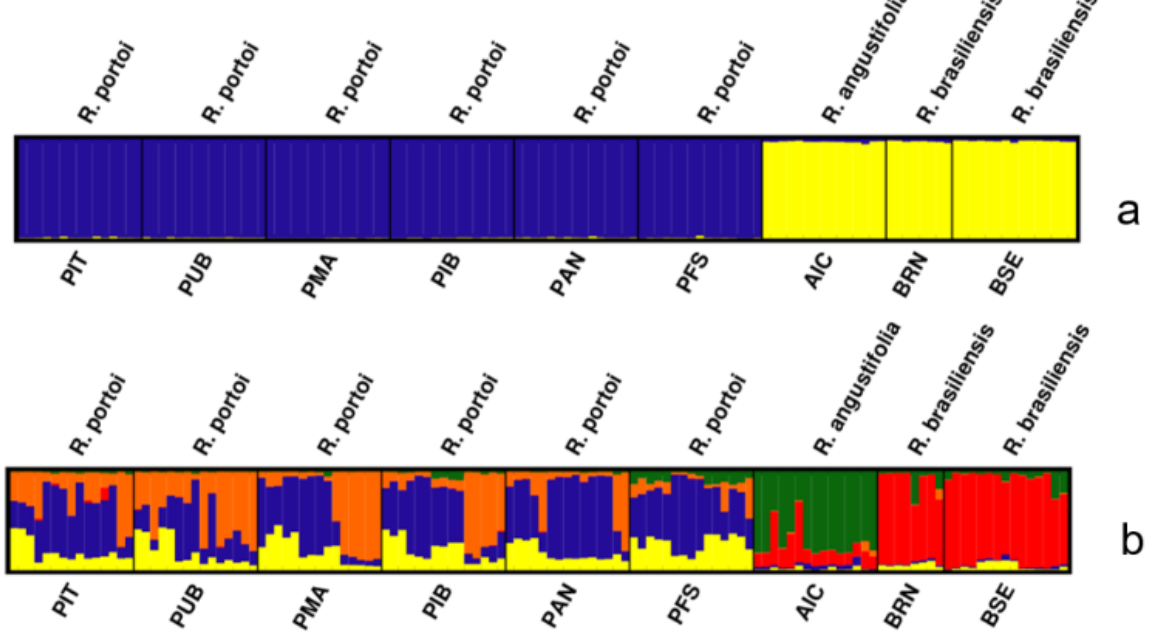
Figure 3. Graphic representations of the structure of the populations of Raddia created based on 20 runs of STRUCTURE with ISSR data, choosing K = 2 ( a ) and K = 5 ( b ). Different colors represent different gene pools, and each vertical bar represents an individual. For population codes, see the sampling subitem on material and methods.